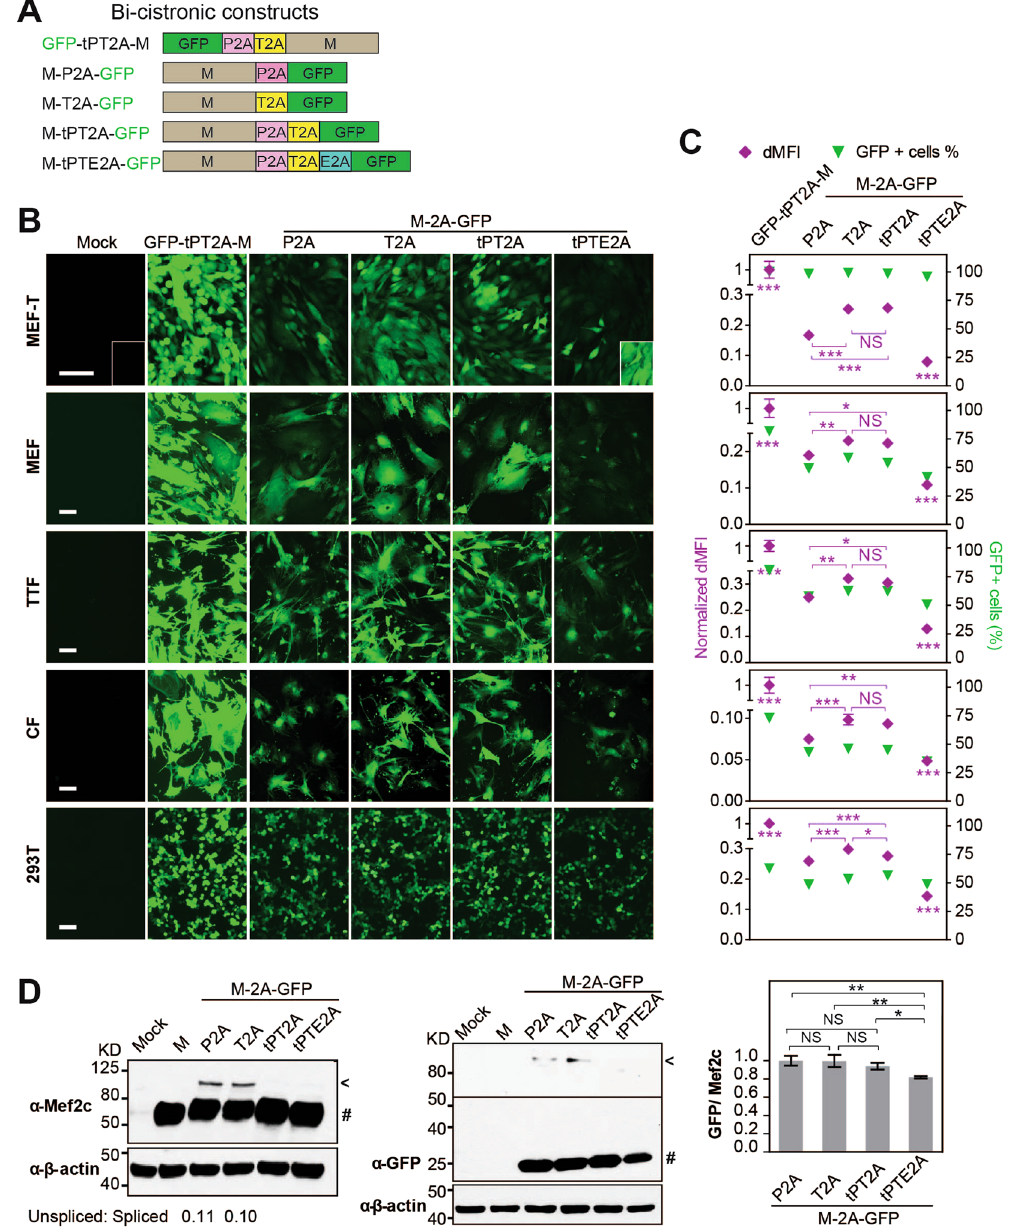
Figure 2. Bi-cistronic 2A constructs: impact of 2A sequences on the expression of the gene at the second position. ( A ) Different bi-cistronic 2A constructs encoding Mef2c (M) and Gfp . “t” is the abbreviation for “tandem.” ( B ) Representative live fluorescent images of various cell types transduced (except transfection in 293 T) with retroviruses (pMXs) encoding the different 2A constructs. MEF, mouse embryonic fibroblast. MEF-T, immortalized MEF cell line 22 . CF, primary cardiac fibroblast. TTF, primary tail-tip fibroblast. Boxed area in MEF-T Mock and M-tPTE2A-GFP are longer exposed to show that the percentage of GFP + cells were 100% for M-tPTE2A-GFP even though GFP intensity is low. Images were taken on day 3 post-transduction or 48 hr post-transfection (293T) at 20X (40X for MEF-T). Scale bar = 100 µ m. ( C ) Cells in ( B ) were collected and quantified for percentage of GFP + cells (green triangle) and the fluorescence intensity of GFP (purple diamond) by flow cytometry. dMFI, delta median fluorescence intensity = MFI of GFP + cells − MFI of GFP − cells. dMFI of all 2A constructs were normalized to that of the GFP-tPT2A-M. ( D ) Western blots showing Mef2c and GFP protein expression in MEF-T cells transduced with different bi-cistronic constructs. # Spliced protein. < Unspliced M-2A-GFP. Middle panel: a longer exposure was used to visualize the unspliced GFP. Right panel: the expression levels of unspliced Mef2c and GFP were quantified and normalized to the β -actin loading control and then GFP/Mef2c ratios in different M-2A-GFP constructs were calculated and further normalized to that in the M-P2A-GFP construct. Mean ± SD of triplicate experiments were shown. Statistical significance was calculated by one-way ANOVA and bonferroni